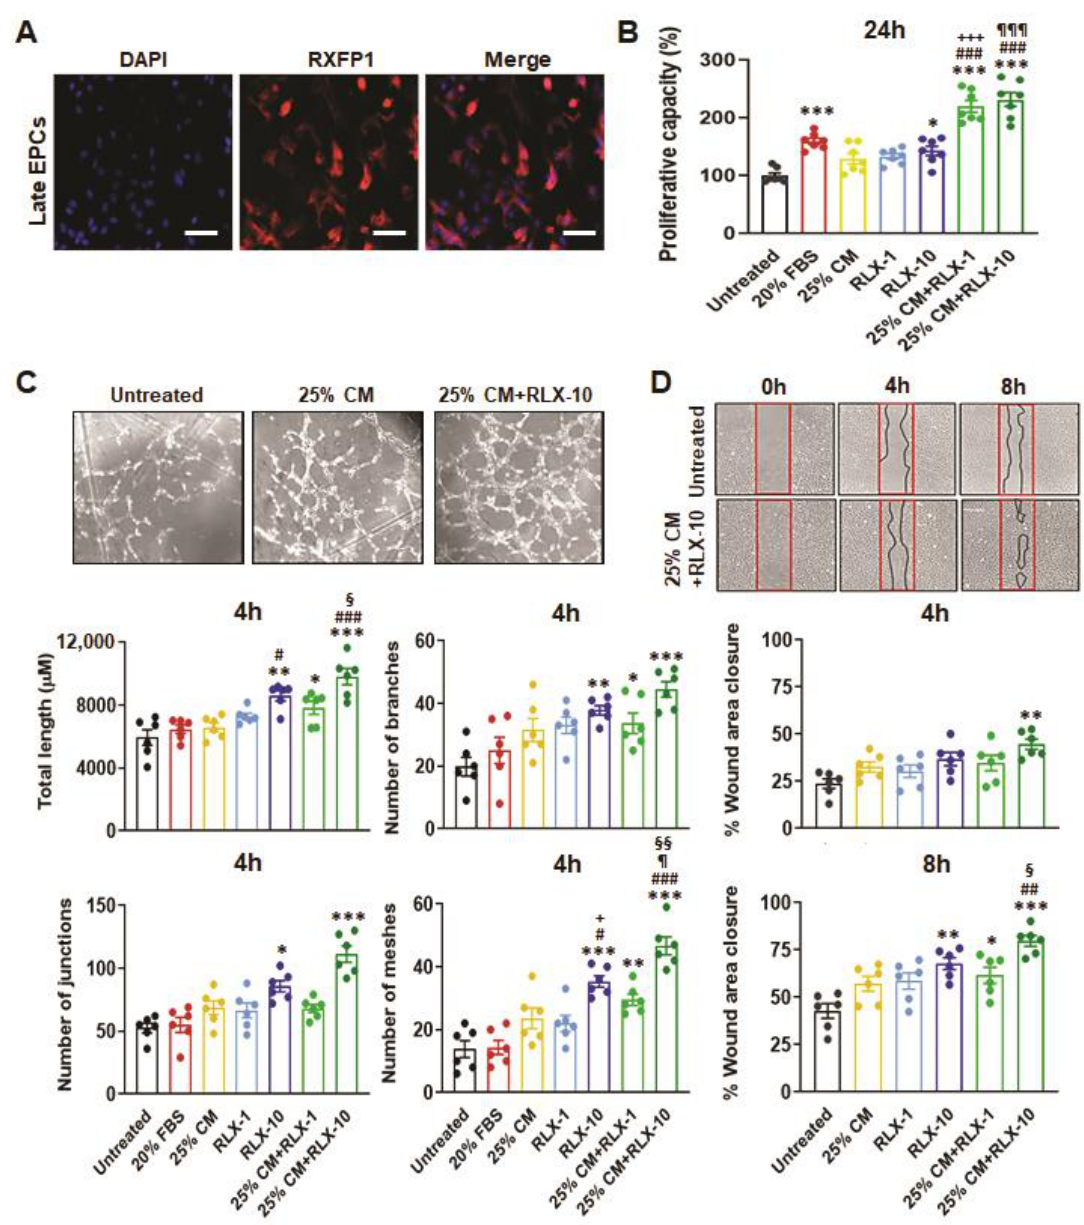
Figure 1. The effects of BM-MSC-derived CM and/or RLX on healthy patient-derived EPC viability/proliferation, angiogenesis and wound healing. CD34 + late EPCs from the blood of healthy male patients were found to express the cognate RLX receptor, RXFP1; scale bar = 50 µm ( A ). EPC proliferation after 24 hours (24 h) from n = 7 patient-derived EPCs per group ( B ); EPC-mediated tube formation (determined from total tube length, number of branches, number of junctions and number of meshes) after 4 h from n = 6 patient-derived EPCs per group ( C ) and EPC-mediated wound healing after 4 h and 8 h from n = 6 patient-derived EPCs per group ( D ), was determined in response to 20% fetal bovine serum (FBS; positive control), 25% BM-MSC-CM (25% CM), RLX [1 ng/mL (RLX-1) or 10 ng/mL (RLX-10)] or the combined effects of 25% CM and RLX-1 or RLX-10. Complete wound closure was achieved by untreated EPCs by 24 h. Representative images of capillary tube formation from untreated EPCs and EPCs treated with 25% CM alone or in combination with RLX-10 ( C ) and of wound closure from untreated EPCs and those treated with 25% CM+RLX-10 ( D ) are shown. The coloured circles in each of the columns of each bar graph represent individual data points from each group. Data were analysed using a one-way ANOVA followed by a Tukey’s post-hoc test to allow for multiple comparisons between groups. * p < 0.05, ** p < 0.01, *** p <